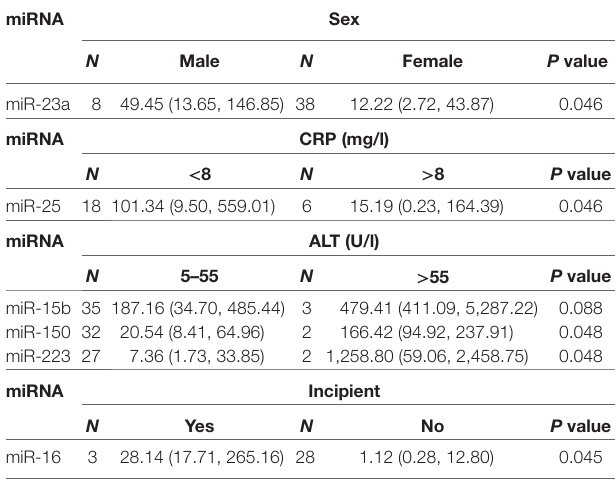
TaBle 7 | Correlation of 14 microRNA (miRNA) expression with other clinical features of systemic lupus erythematosus. mirna sex